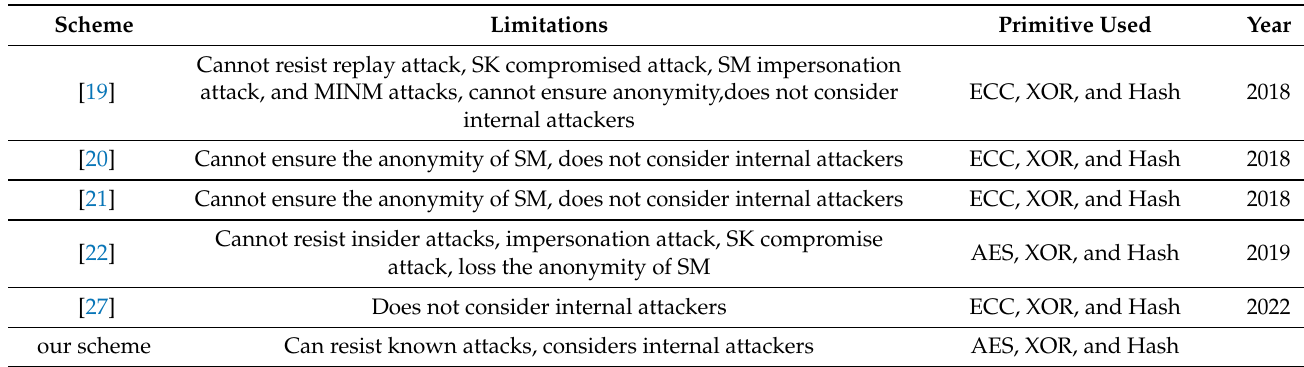
Table 1. Overview of authentication